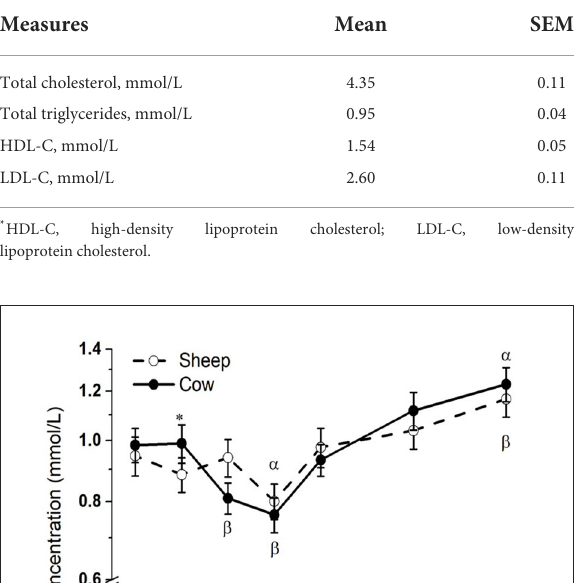
TABLE 3 Anthropometric and biochemical characteristics of the participants at baseline.